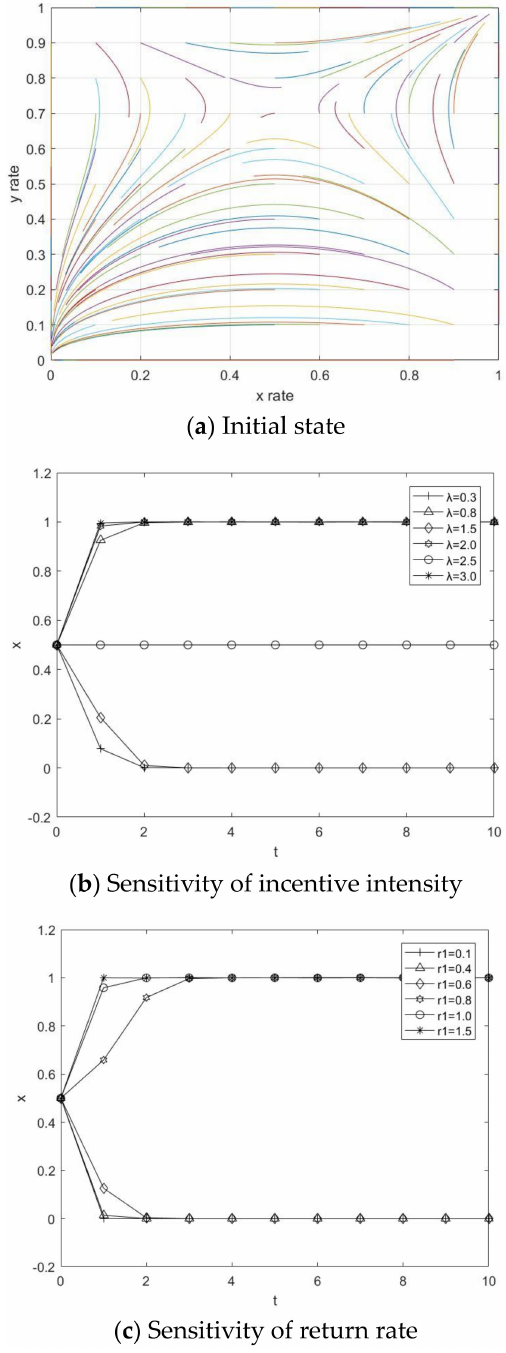
Figure 2. Sensitivity of key factors of private enterprises’ participation